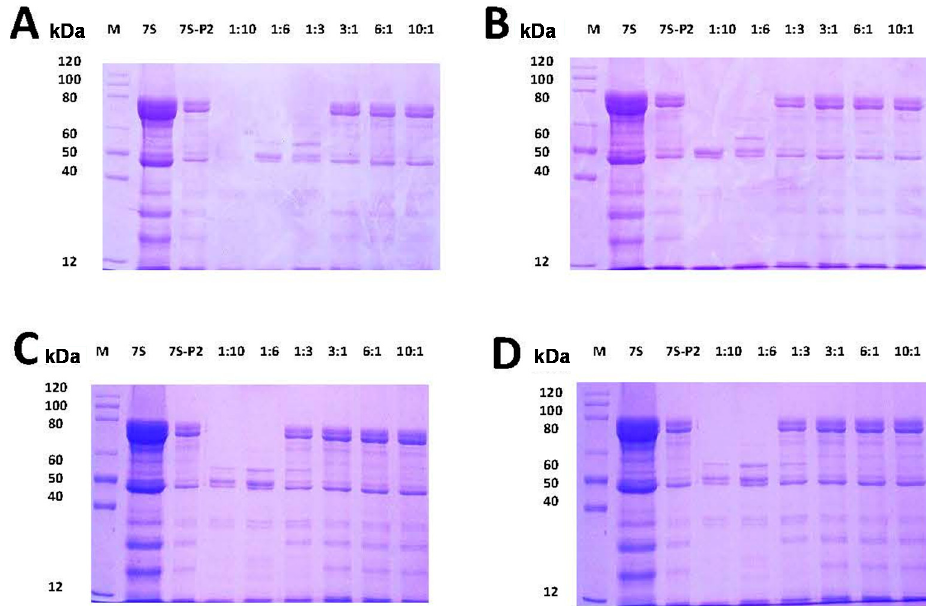
Figure 7. SDS-PAGE analysis of the digestive stability of soy protein 7S in the absence and presence of: PCA ( A ); CA ( B ); GA ( C ); and CGA ( D ) at different concentrations in simulated gastric fluid (pH 2.0). Conditions: [soy protein 7S] = 3 μ M; the ratios of protein to phenolic acid: 1:10, 1:6, 1:3, 3:1, 6:1 and 10:1. “7S-P2” represents a mixture of pepsin and soy protein 7S in the absence of phenolic acids.